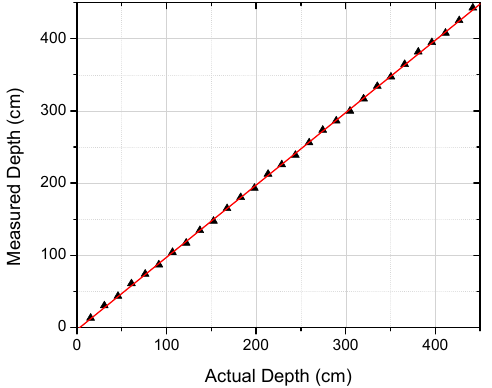
Figure 4. Test results of the depth probe showing the relationship between measured and expected depth.